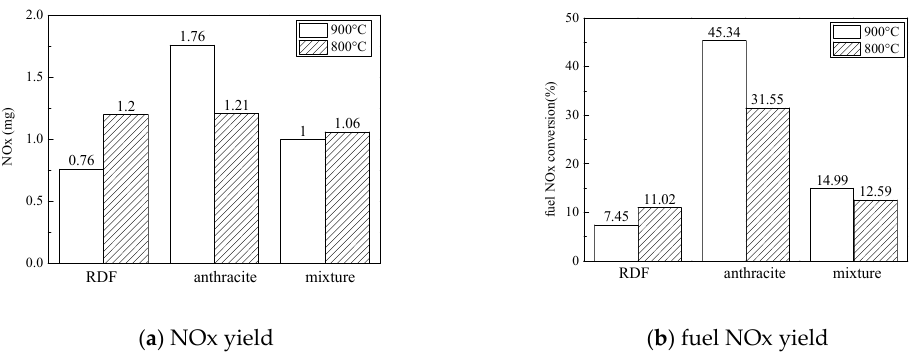
Figure 7. NOx emission yield and fuel NOx conversion at different temperatures.